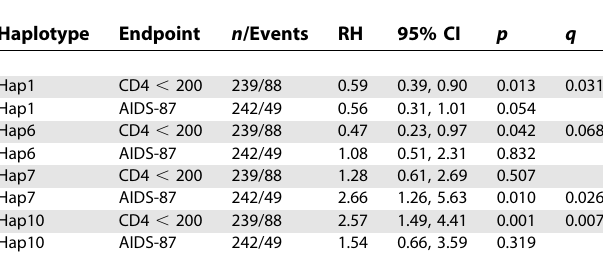
Table 2. Effects of Selected CUL5 Haplotypes on